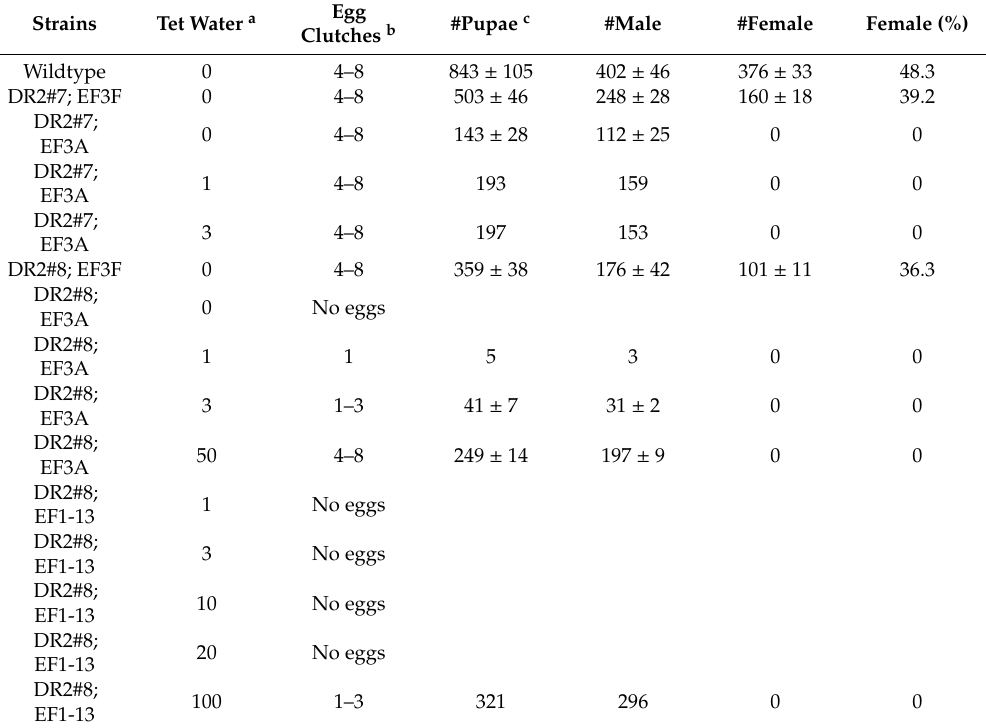
Table 1. Female fertility and lethality tests for di ff erent double homozygous